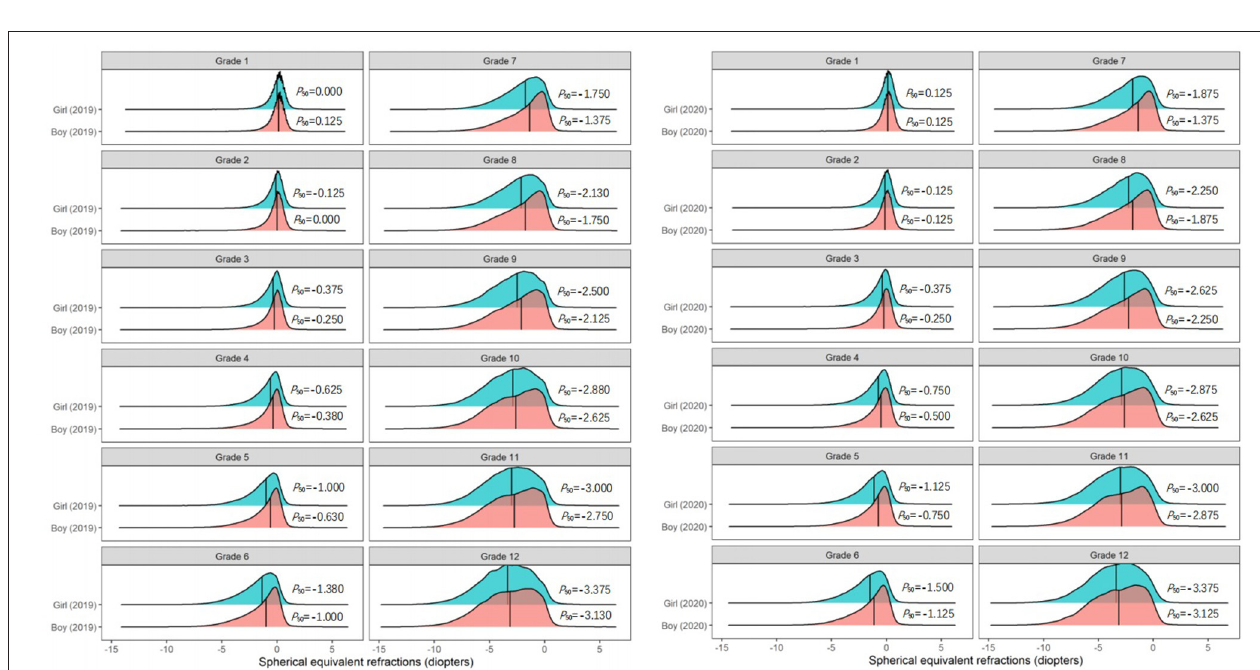
FIGURE 4 | The distribution curves of spherical equivalent refraction of each eye among elementary and middle school students in 2019 and 2020.